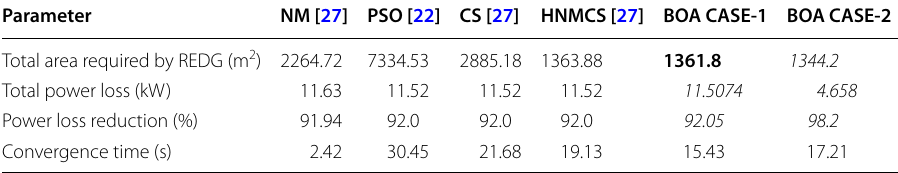
Italis values are represents better values